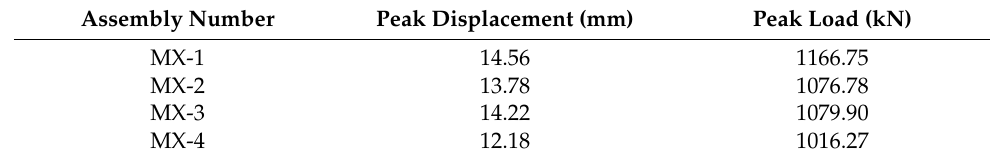
actual test piece MX-2, ( e ) shear-stress contour of the wallboard of virtual test piece MX-3-1, ( f ) failure morphology of the actual test piece MX-3, ( g ) shear-stress contour of the wallboard of virtual test piece MX-4-1, and ( h ) failure morphology of the actual test piece MX-4. Table 6. Cumulative energy consumption of specimens at different